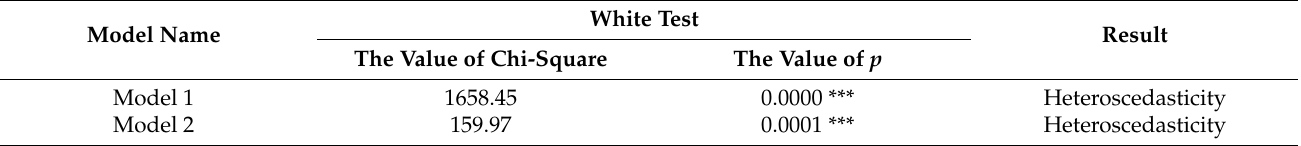
Table 5. Results of the heteroscedasticity test.